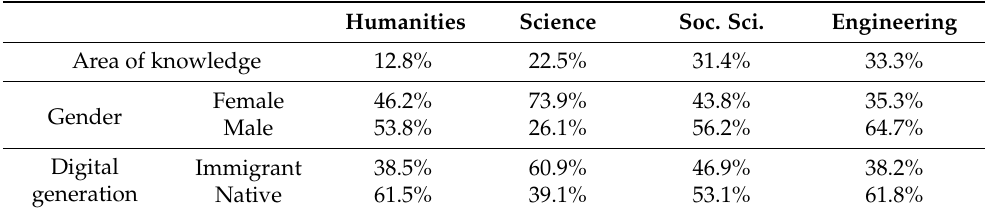
Table 3. Percentage distributions of participants by areas of knowledge and differentiating by the values of the other independent variables.